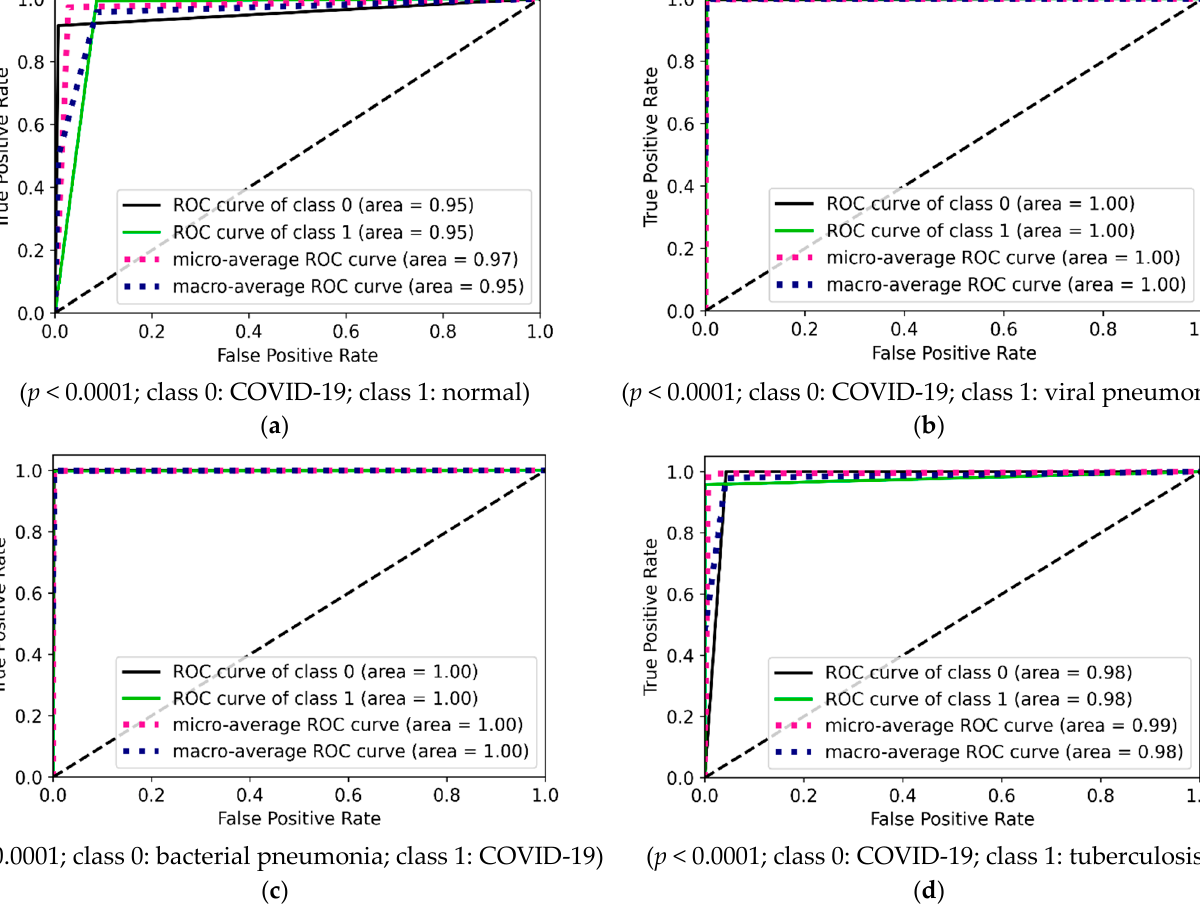
Figure 22. ROC curves and AUC values for two-class experiments: ( a ) COVID-19 and normal by VGG16; ( b ) COVID-19 and viral pneumonia by NasnetMobile; ( c ) COVID-19 and bacterial pneumonia by Densenet201; ( d ) COVID-19 and tuberculosis by VGG16.